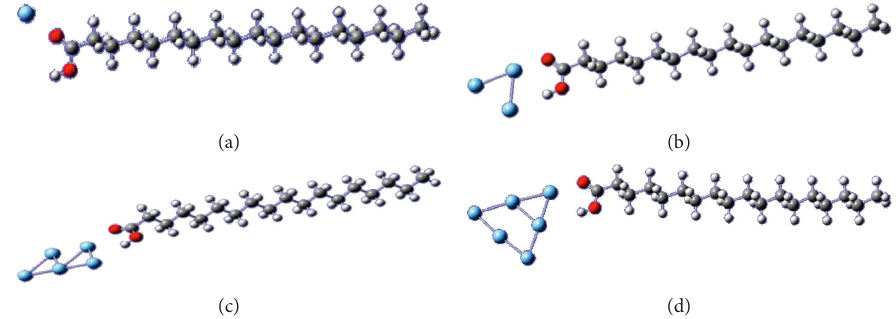
Figure 3: Optimized geometries of stearic acid with (a) a single silver atom, (b) cluster of 3 silver atoms, (c) cluster of 5 silver atoms, and (d) cluster of 6 silver atoms.